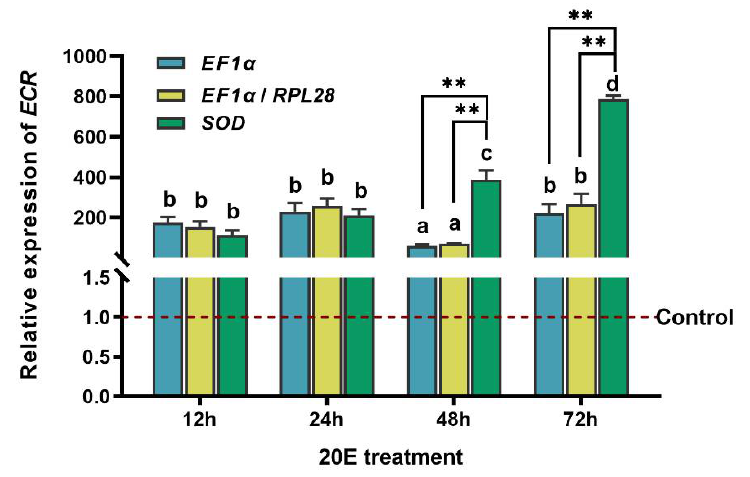
Figure 4. Validation of reference genes. Relative expression level of EcR was detected by RT-qPCR at 12, 24, 48, and 72 h after 20E treatment. Three reference genes combination ( EF1α , EF1α+RPL28 , SOD ) were used for the normalization. The data are denoted as mean ± standard error (SE). Asterisk indicates that the expression of EcR normalized by each reference gene(s) was significantly different (** p < 0.01, two-way ANOVA followed by Tukey’s multiple comparison test).